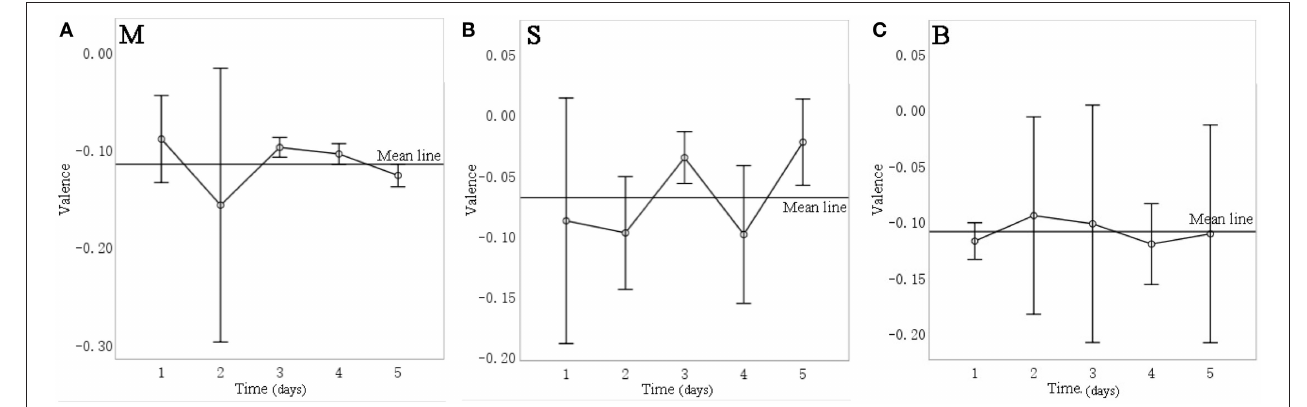
FIGURE 11 | Changes in valence over 5 days of experiment for different sound interventions. (A) music, (B) stream, (C) birdsong.